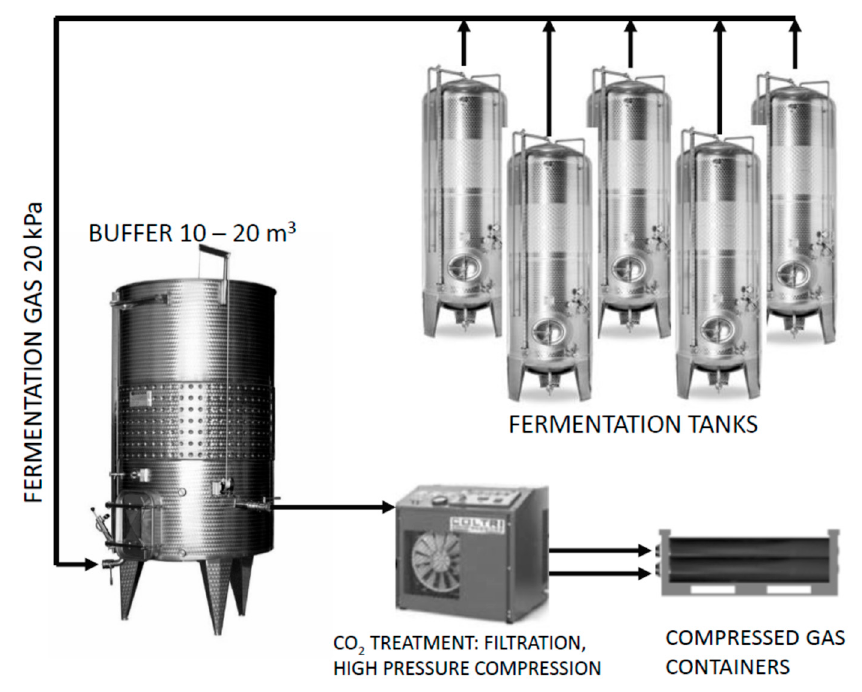
Figure 1. Scheme of the fermentation gas collection system.